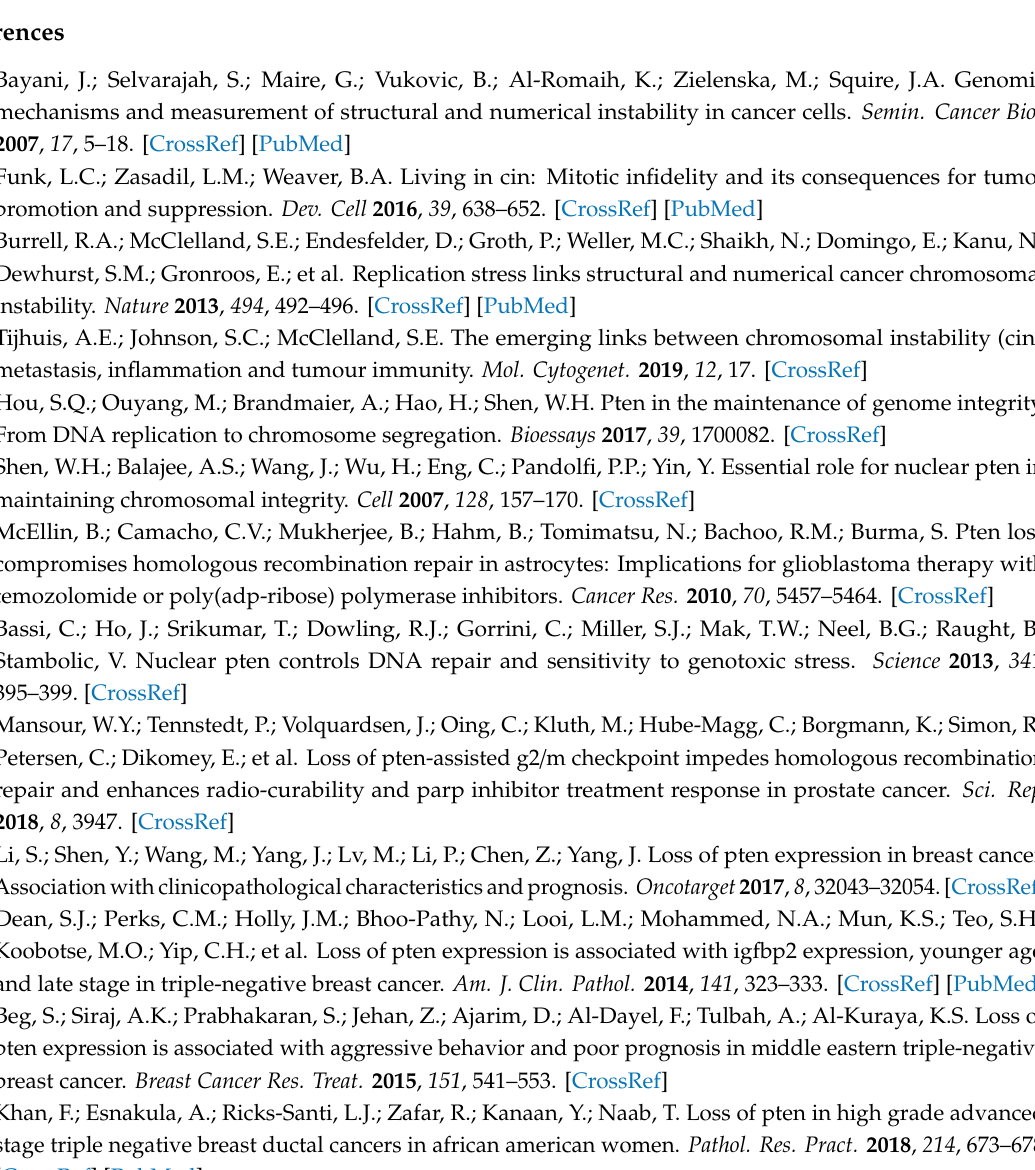
Figure S1: Raw data of Western blot from Figure 1b, Figure S2: Raw data of Figure 2a for elongation rate, Figure 2b for origin firing. Figure S3: Raw data from DNA fiber analysis. Figure S4. Fork instability after HU treatment in SKBR3, MCF7, T47D and BT474. Figure S5: Raw data of Western blot from Figure 6a. Figure S6: Raw data from Western blot of Figure 6b. Figure S7: PTEN expression and recruitment of DNA repair proteins to the chromatin in TNBC. Figure S8. Comparison of TNBCs with low PTEN expression to TNBC with high PTEN expression in replication fork elongation, stalling and new origin firing untreated and upon PARP1